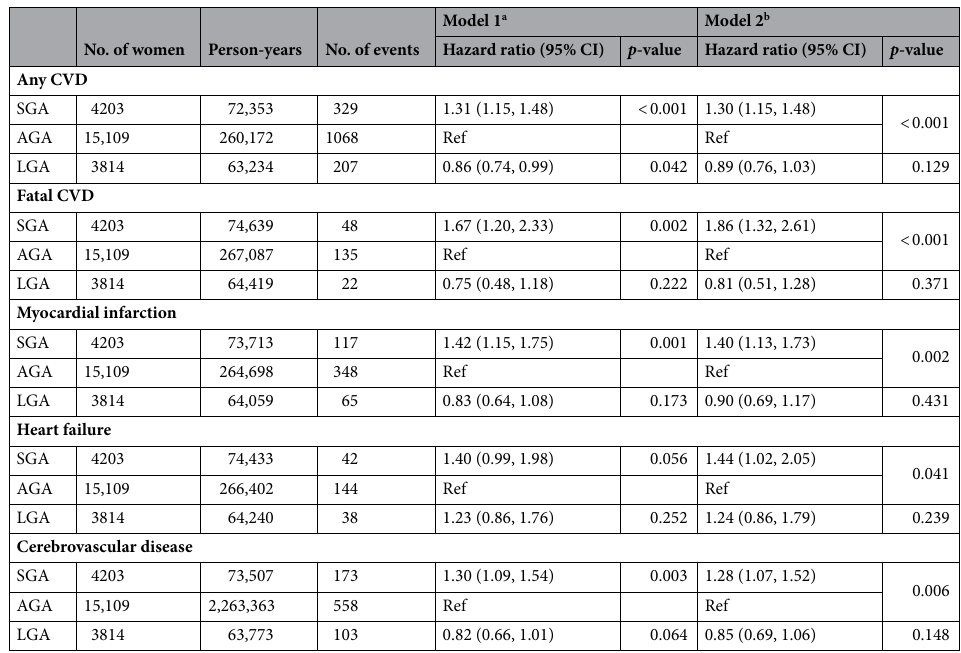
Table 2. Hazard ratios for cardiovascular events in women by history of SGA or LGA offspring. a Adjusted for age. b Adjusted for age, highest obtained educational level, parity before age 40, maternal birth year, maternal height and family history of coronary heart disease. SGA small for gestational age, LGA large for gestational age, CI confidence interval, CVD cardiovascular disease, AGA appropriate for gestational age.